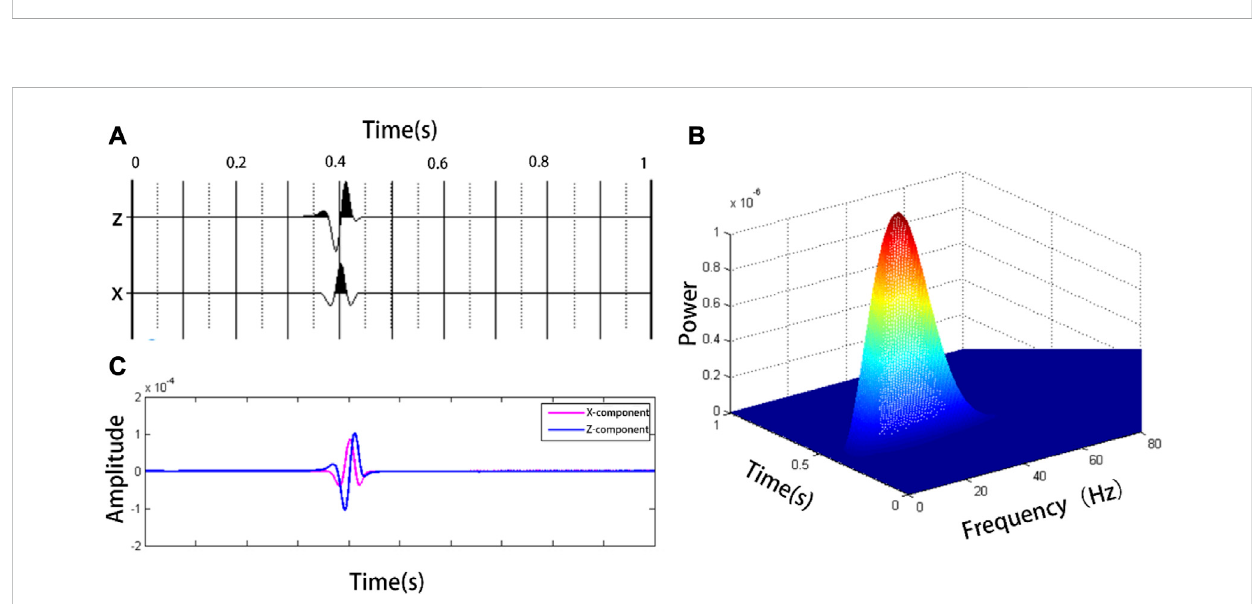
Figure 10A shows a group of three-component original microtremor seismic records dominated by body waves with a duration of 10s. From the time-frequency energy distribution diagram (Figure 10B) of the vertical component seismic record Z, it can be seen that the energy of the microtremor signal in this section is approximately 20 Hz, and there is a series of wave groups with strong energy in approximately 5 s. The maximum point of its energy is (4.96 s, 24 Hz). The three-component seismic record was band-pass fi ltered at 24 Hz and the fi ltering range was determined according to the energy distribution. The seismic record stacking diagrams of the fi ltered vertical and horizontal components are